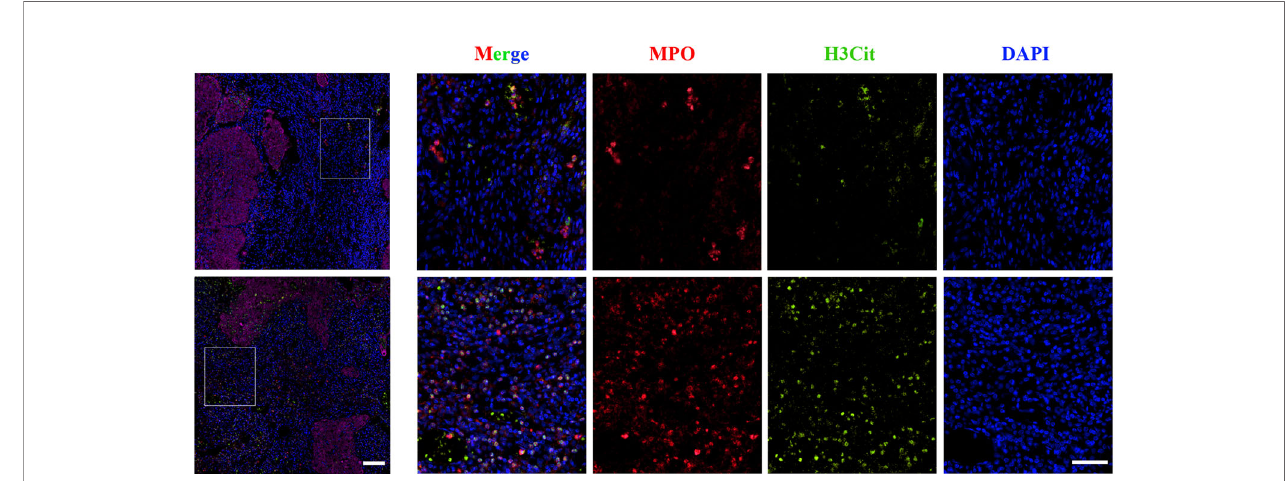
FIGURE 3 | Representative images of immuno fl uorescence staining of low (upper panel) and high (lower panel) NET density in cervical cancer samples. Magni fi cation 4×, scale bar = 100 m m; magni fi cation 20×, scale bar = 100 m m. MPO, Red; H3Cit, Green; DAPI, Blue.